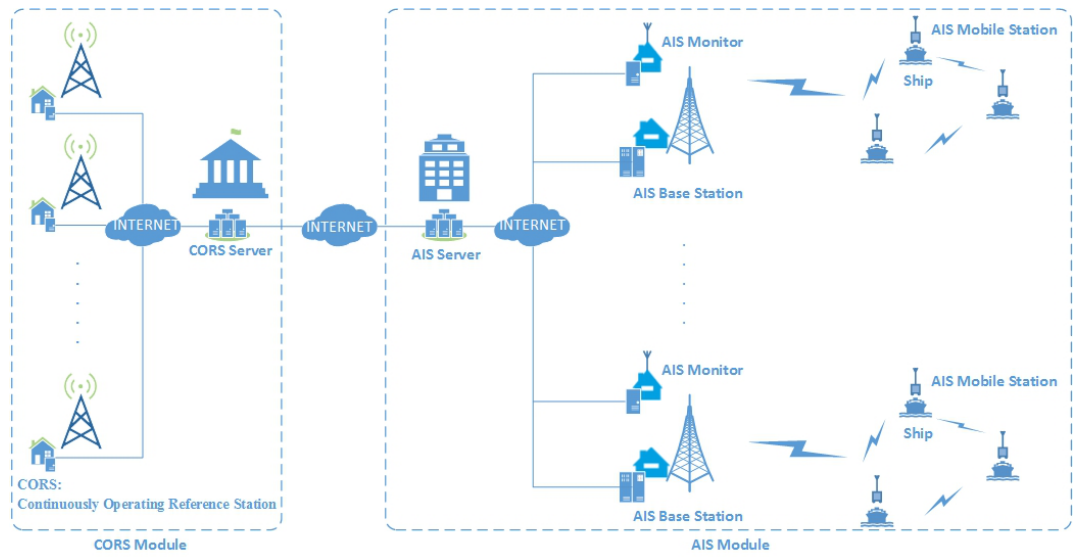
Figure 1. The conceptual model of the differential correction approach for AIS mobile